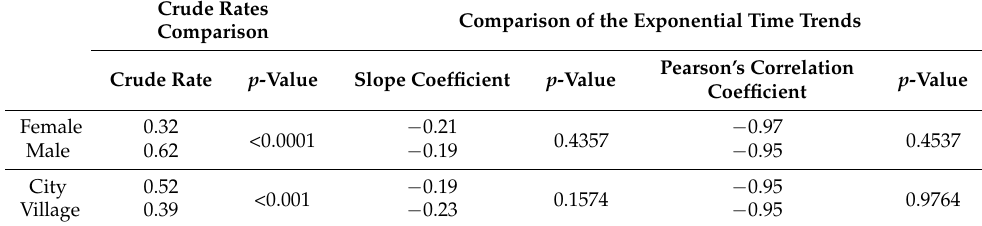
Figure 2. Acute Hepatitis B incidence trends for males and females in Poland, 2005–2019. Table 1. Comparison of the direction and strength of trends in acute Hepatitis B incidence in Poland according to sex and place of residence, 2005–2019.